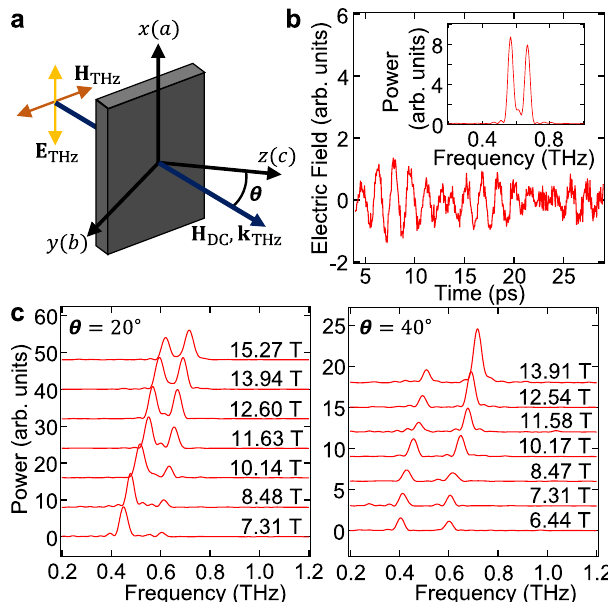
Fig. 2 Magnon signals in time and frequency domains. a Schematic of THz magnetospectroscopy studies of YFeO 3 in a tilted magnetic fi eld. H DC was applied in the b − c plane at an angle of θ with respect to the c -axis, with k THz // H DC and H THz polarized in the b − c plane. b Transmitted THz waveform for θ = 20 ∘ at H DC = 12.60 T displaying beating in the time- domain and two peaks in the frequency domain corresponding to the simultaneous excitation of both magnon modes in YFeO 3 . c Magnon power spectra for θ = 20 ∘ and θ = 40 ∘ at different H DC displaying larger frequency splitting for larger θ